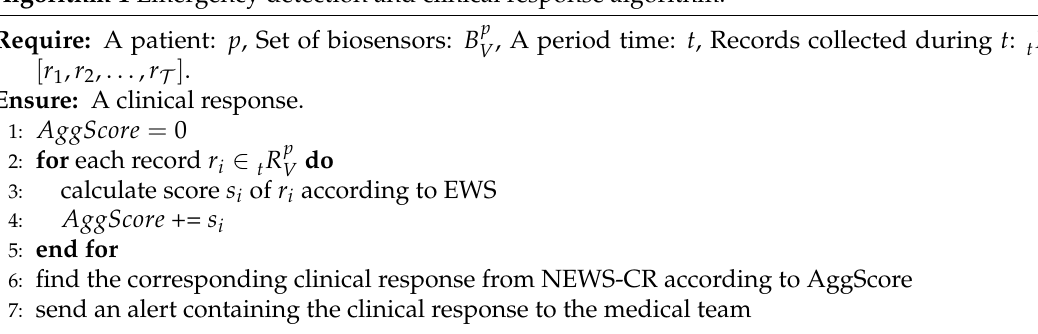
Algorithm 1 Emergency detection and clinical response